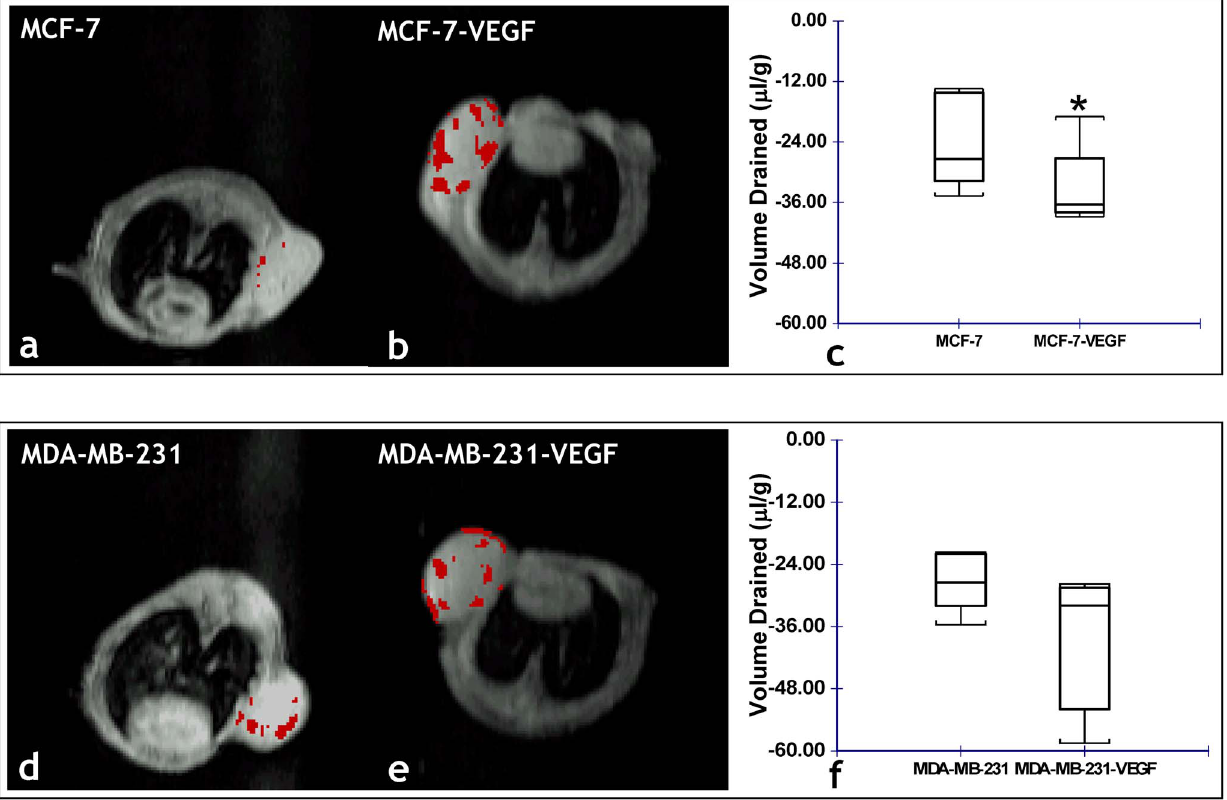
Figure 6. Invivo MRI reveals VEGF overexpression alters the ECM of MCF-7 tumors. Representative functional MRI maps of the volume of extravascular fluid drained from: (a) MCF-7 and (b) MCF-7-VEGF overexpressing tumor xenografts. (c) Box-and-whisker plot comparing the volume drained between MCF-7 (n=5) and MCF-7-VEGF (n=5) xenografts (*p=0.0277 with the one-tailed Mann-Whitney U Test). Representative functional MRI maps of the volume of extravascular fluid drained from: (d) MDA-MB-231 and (e) MDA-MB-231-VEGF overexpressing tumor xenografts. (f) Box- and-whisker plot comparing the volume drained between MDA-MB-231 (n=5) and MDA-MB-23-VEGF (n=4) xenografts.